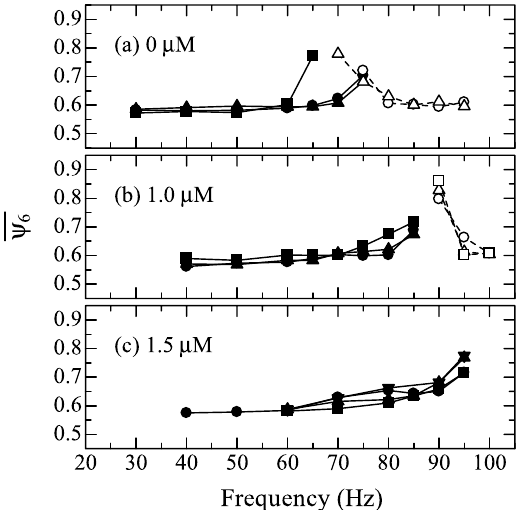
Figure 3. Averaged bond orientational order parameters after oscillations for 60 s. Polymer concentrations are ( a ) 0.0, ( b ) 1.0, and ( c ) 1.5 μ